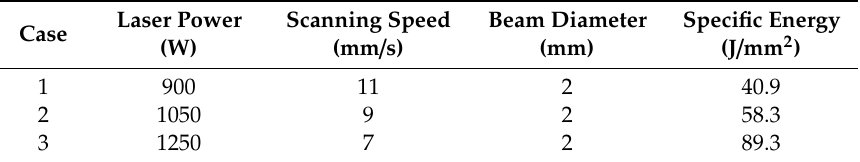
Table 2. Laser cladding experiment parameters.